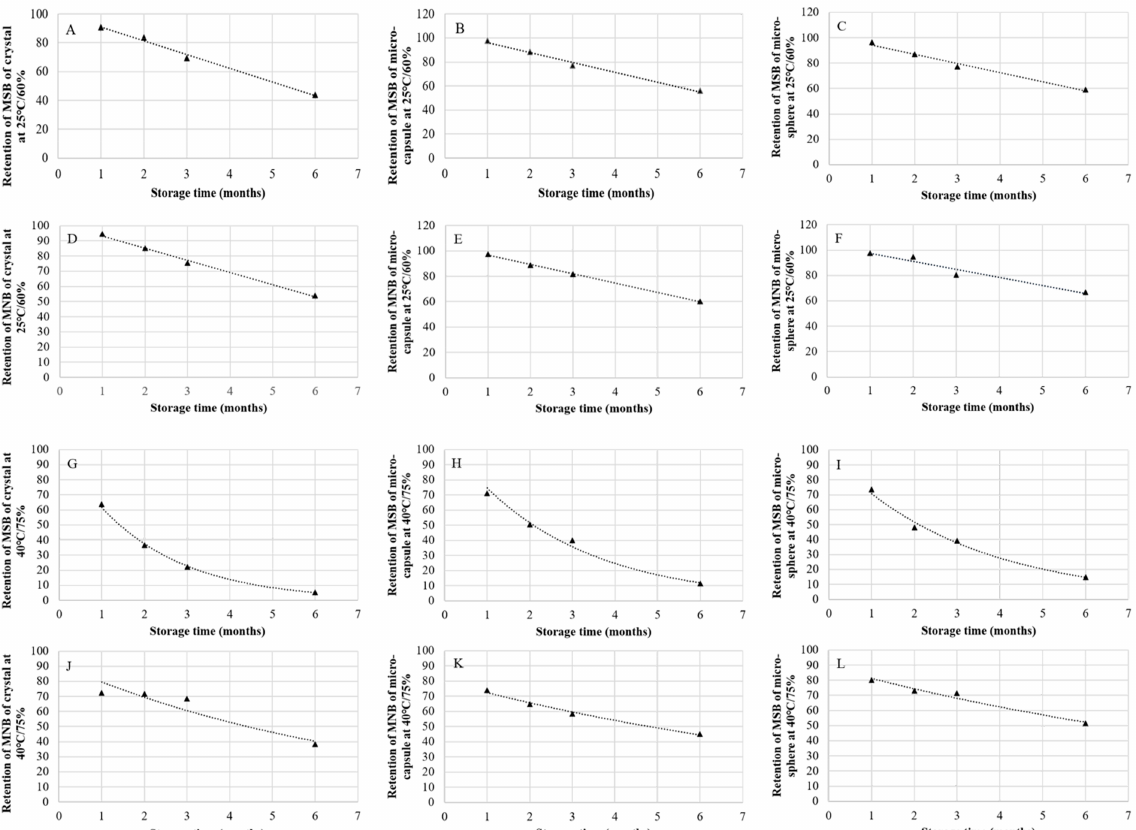
Figure 1. Prediction equations for vitamin K 3 retention (%) in vitamin premixes during storage. ( A ) Retention of MSB of crystal at 25 ◦ C/60% (y = − 9.5807x + 100.58, R 2 = 0.992); ( B ) Retention of MSB of micro-capsule at 25 ◦ C/60% (y = − 8.255x + 104.43, R 2 = 0.990); ( C ) Retention of MSB of micro-sphere at 25 ◦ C/60% (y = − 7.2871x + 101.66, R 2 = 0.985); ( D ) Retention of MNB of crystal at 25 ◦ C/60% (y = − 8.0286x + 101.26, R 2 = 0.994); ( E ) Retention of MNB of micro-capsule at 25 ◦ C/60% (y = − 7.3439x + 103.92, R 2 = 0.999); ( F ) Retention of MNB of micro-sphere at 25 ◦ C/60% (y = − 6.3364x + 103.8, R 2 = 0.943); ( G ) Retention of MSB of crystal at 40 ◦ C/75% (y = 101.26e − 0.498x, R 2 = 0.999); ( H ) Retention of MSB of micro-capsule at 40 ◦ C/75% (y = 107.69e − 0.367x, R 2 = 0.991); ( I ) Retention of MSB of micro-sphere at 40 ◦ C/75% (y = 96.72e − 0.313x, R 2 = 0.994); ( J ) Retention of MNB of crystal at 40 ◦ C/75% (y = 91.176e − 0.136x, R 2 = 0.901); ( K ) Reten- tion of MNB of micro-capsule at 40 ◦ C/75% (y = 79.747e − 0.097x, R 2 = 0.991); ( L ) Retention of MNB of micro-sphere at 40 ◦ C/75% (y = 88.783e − 0.088x, R 2 = 0.974). MSB, menadione sodium bisulfite; MNB, menadione nicotinamide